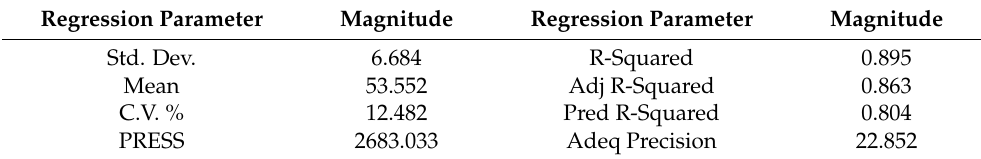
Table 10. Regression statistics